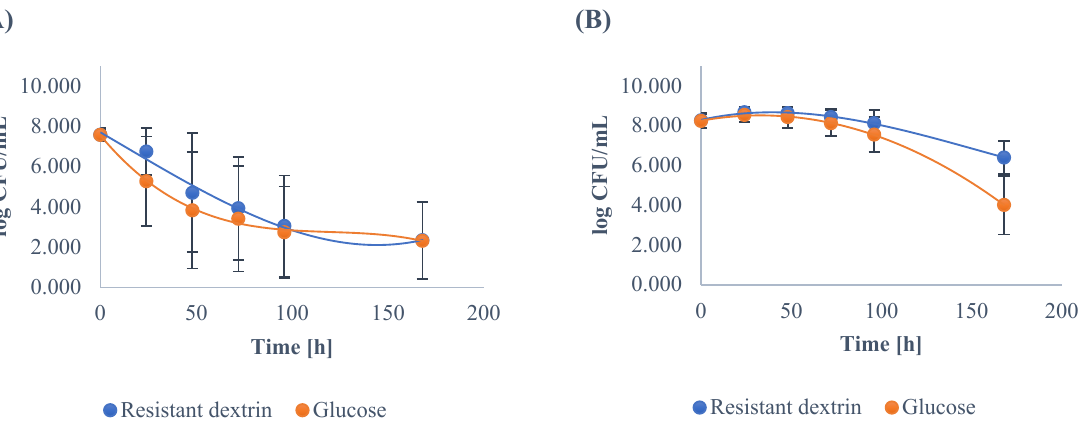
Figure 2. The growth of E. coli ( A ) and Enterococcus ( B ) in the medium enriched with the resistant dextrin and with glucose as the control. The results show the means and standard deviations. Strains of Clostridium and Bacteroides were similarly able to utilize resistant dextrin for growth and reached 8.38 ± 0.58 and 8.70 ± 0.30 log CFU/mL in their respective stationary phases (Figure 3). Moreover, the trend during their respective growth was similar to the Enterococcus genera. The counts of Clostridium and Bacteroides were significantly higher than in the case of control group (after 96 h of cultivation); however, it was still a less significant increase than the one measured for the Lactobacillus and Bifidobacteria.